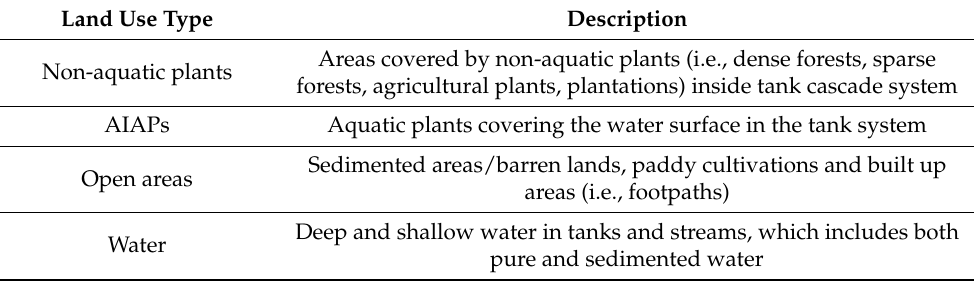
Table 2. Description of the four land use classes used in the image